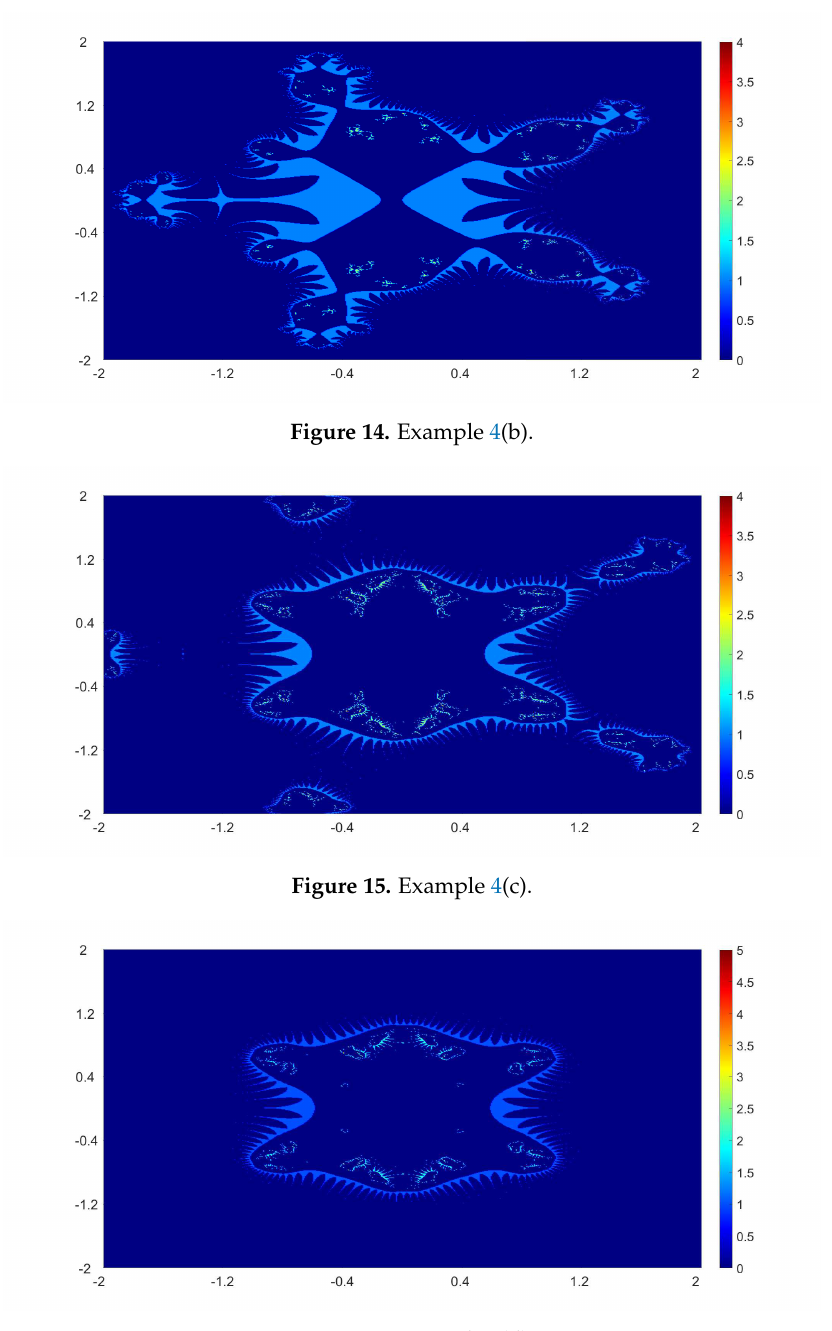
Figure 16. Example